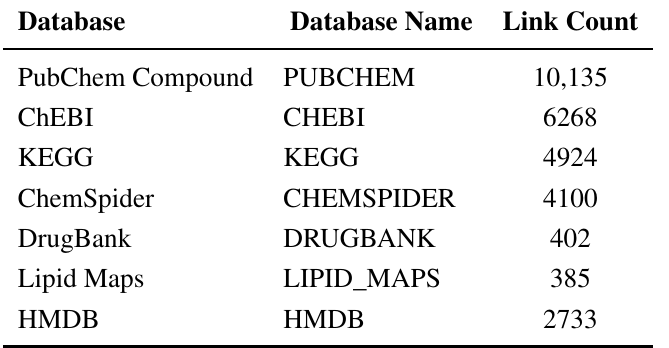
Table 1. The metabolite databases to which BioCyc databases currently contain significant numbers of external links, for which external identifier searches are therefore likely to work; the names for those databases used in BioCyc searches; and the number of links to